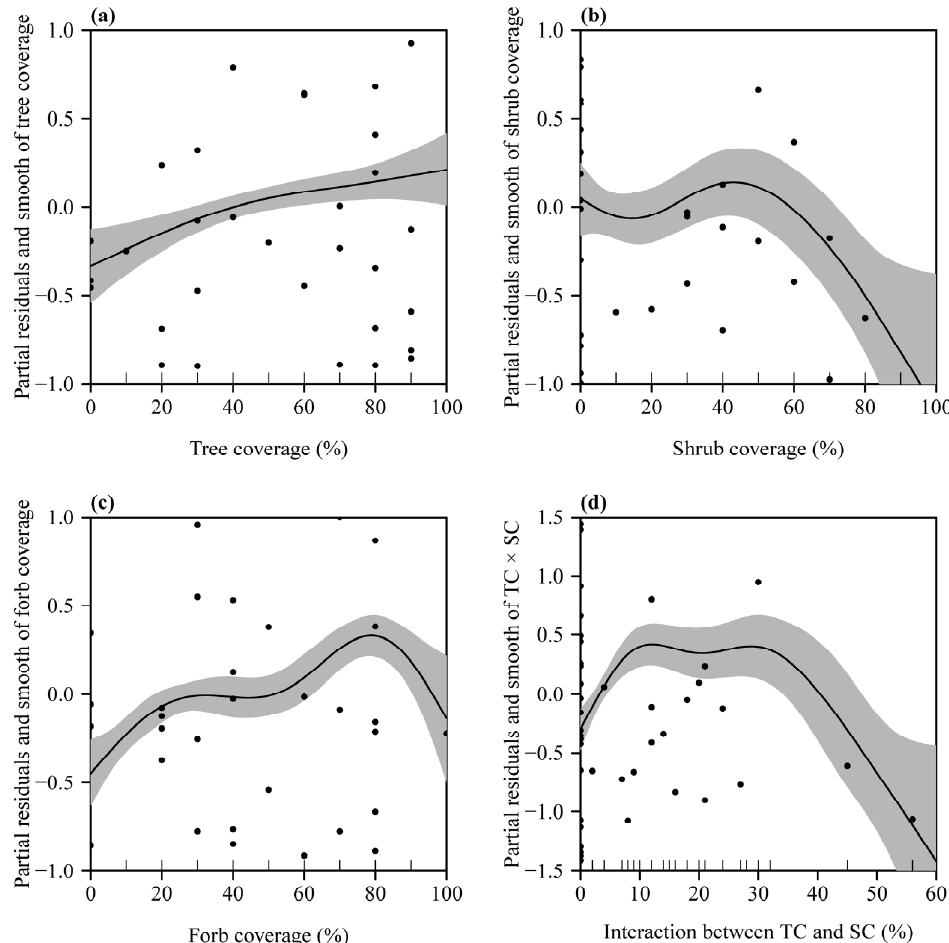
Figure 3. Partial residuals and smooth of each of the four plant coverage variables. ( a ) Coverage of trees; ( b ) coverage of shrubs; ( c ) coverage of forbs; ( d ) the interaction between the coverage of trees (TC) and that of shrubs (SC). In panels ( a – d ), the closed points represent the partial residuals; the solid curve represents the estimate of each 1-D smooth; and the gray area represents two standard errors above and below the estimate of the smooth.